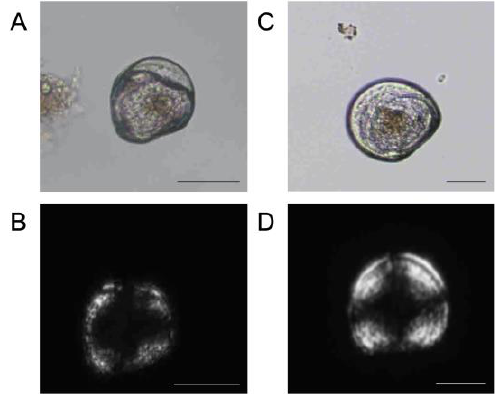
Figure 5. Photomicrographs showing altered (( A ) and ( B ), from the DsiRNA-perlucin/pH = 7.3 treatment) and normal (( C ) and ( D ), from control no DsiRNA treatment reared at pH = 8.2) larvae viewed under brightfield (( A ) and ( C )) or cross-polarized light (( B ) and ( D )) microscopy. Note the lower refringence in B indicative of lower biomineralization as compared to ( D ). Images taken with Nikon Eclipse TE2000-S inverted microscope. Scale bars = 50 µ m.